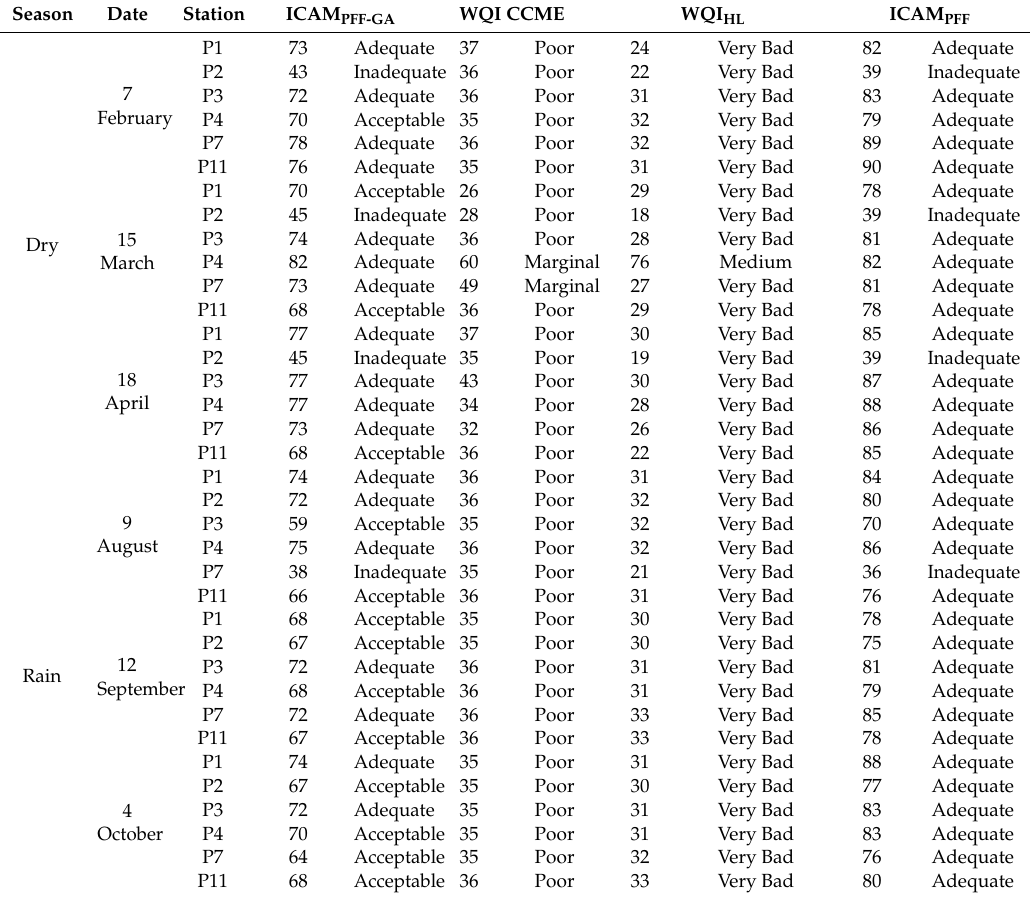
Table 8. Values of water quality indexes for the monitoring